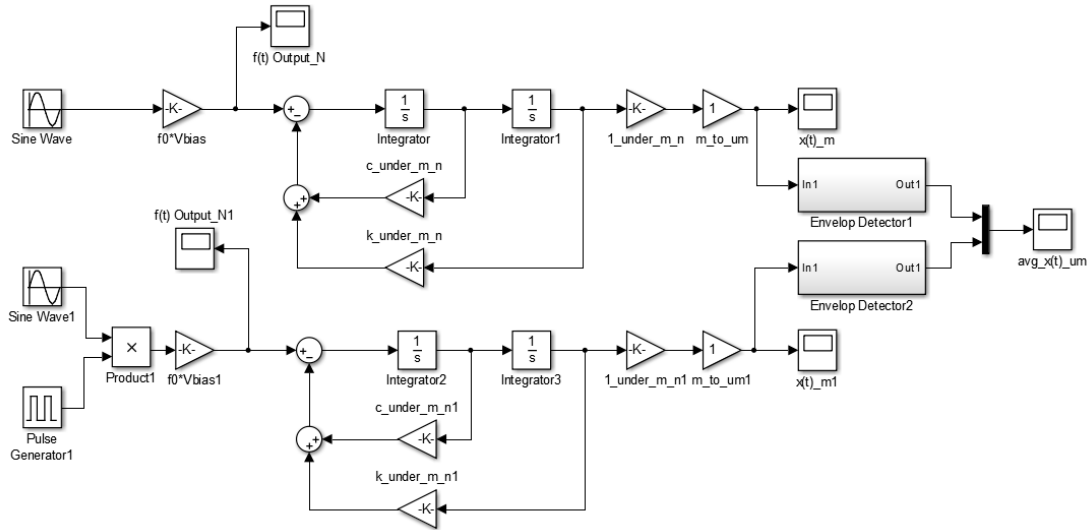
Figure 4. Simulation SW to verify the analytic results of the time response by switched excitation.